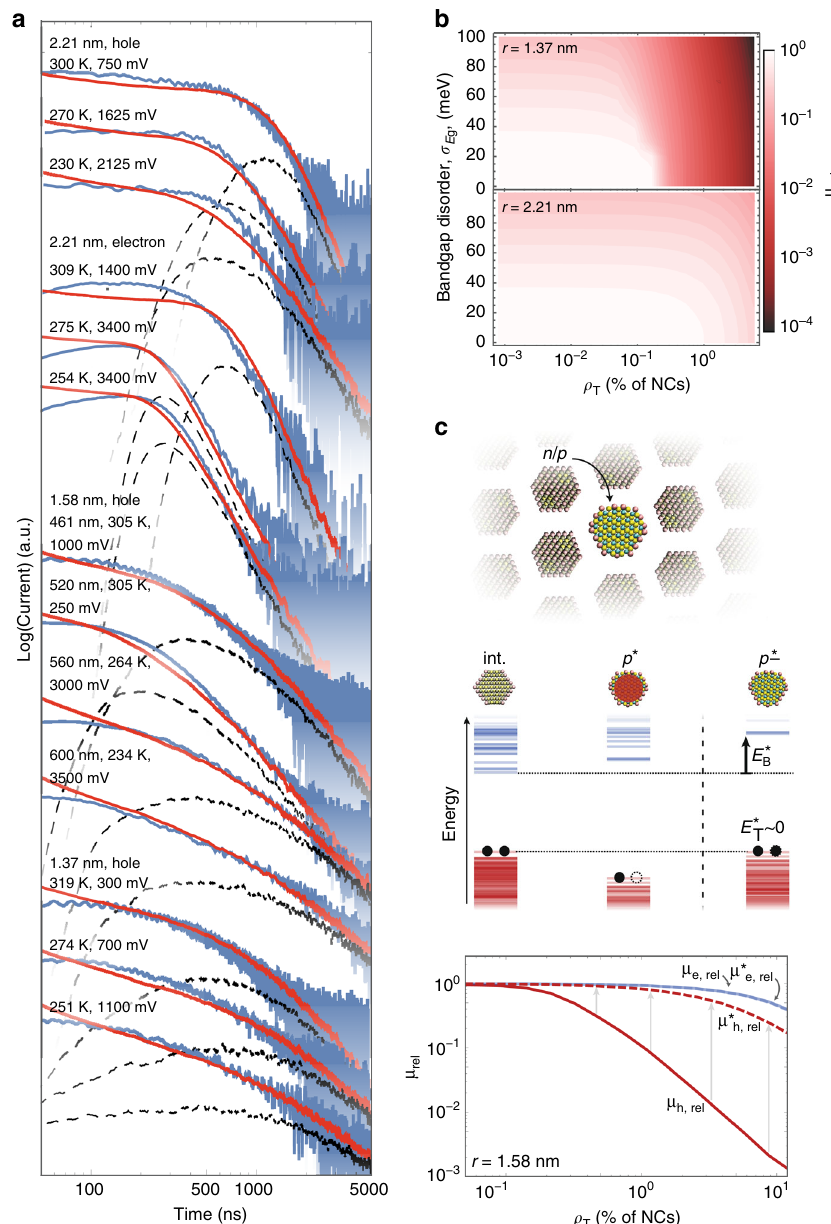
Fig. 4 Predictive model for charge transport. a Measured TOF transients (blue) and Kinetic Monte Carlo (KMC) simulated transients (red) are shown for various NC sizes, temperatures, biases, and device thicknesses. Distribution of carrier transit times from the simulated transients (dashed black line). b Plot of the ratio of the effective mobility as a function of trap density ρ T and NC band gap disorder σ E g to the effective mobility of a trap and disorder-free NC solid for smaller (top) and larger (bottom) NC sizes, calculated for a 400-nm-thick NC solid at 300 K. c Doping without the formation of trap states can be achieved by introduction of larger-band gap, n - or p -doped NCs. Simulations demonstrate that this prevents a decrease in effective mobility at high carrier